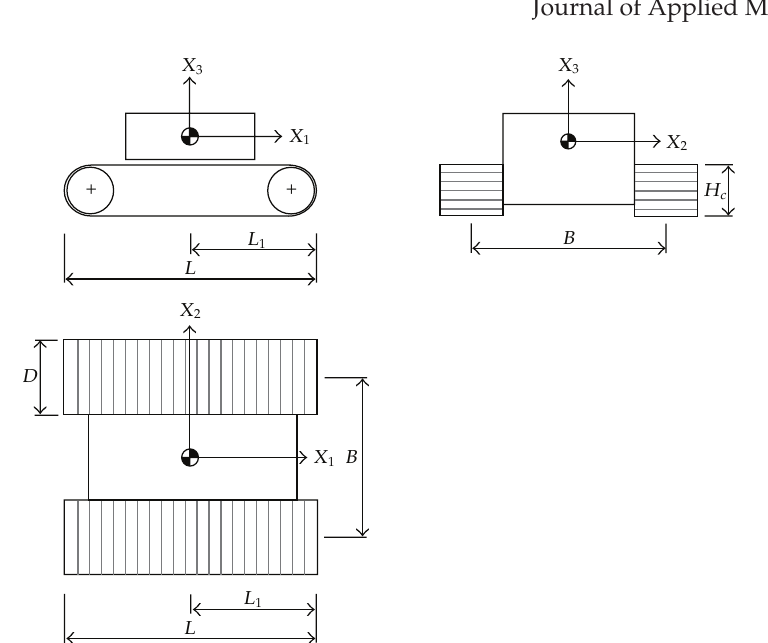
Figure 4: Configuration of tracked vehicle model and description of design